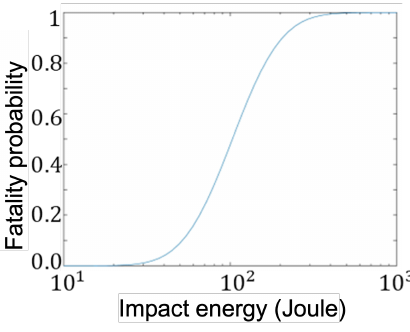
Figure 4. The RCC fatality model with parameters a = 103 Joule and b =